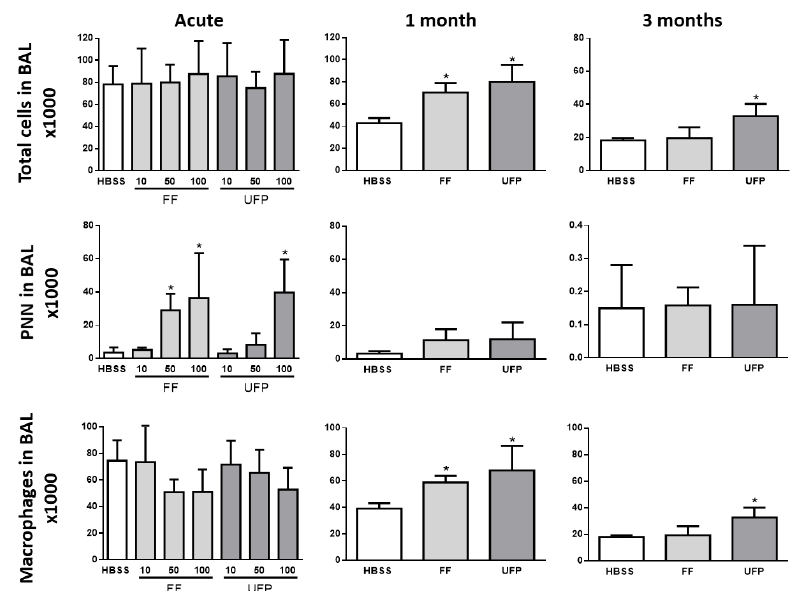
Figure 4. Inflammatory response analysis in BAL of mice exposed to FF and UFP. Histograms show BAL cell count in BAL of mice exposed for 24 h, 1 or 3 months: total cellularity, total number of PNN, total number of macrophages; n = 5 per condition; * p ≤ 0.05 vs Control; ** p ≤ 0.01 vs Control; *** p ≤ 0.001 vs Control; # p ≤ 0.05 vs FF.